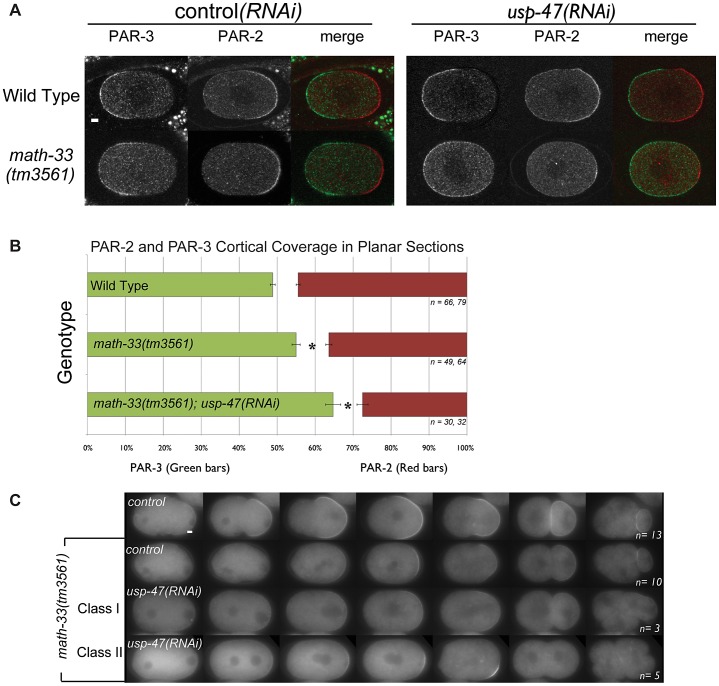
Polarity defects in math-33(tm3561);usp-47(RNAi) embryos.(A) Confocal micrographs of embryos immunostained for PAR-3 (green) and PAR-2 (red). Compared to controls, PAR-3 occupies a larger region of the cortex and PAR-2 a smaller region in the math-33(tm3561); usp-47(RNAi) embryo. (B) Averages of PAR-3 and PAR-2 domain sizes in immunostained embryos as a percentage of embryo length. n indicates the number of anterior and posterior domains examined respectively. Asterisks mark statistical significance compared to wild type, p<0.01, by Student's t-test. (C) Time-lapse images displaying the dynamic localization of PAR-2::GFP in the indicated genotypes. The embryo genotype of the control row (top) showing wild-type behavior is par-2::gfp; math-33(tm3561)/nT1. math-33(tm3561); usp-47(RNAi) embryos weakly recruit PAR-2 and could be grouped into two classes: those that maintain a PAR-2 domain throughout the cell cycle (class I), and those in which the weak PAR-2 domain is not maintained (class II). Scale bars represent 5 µm.